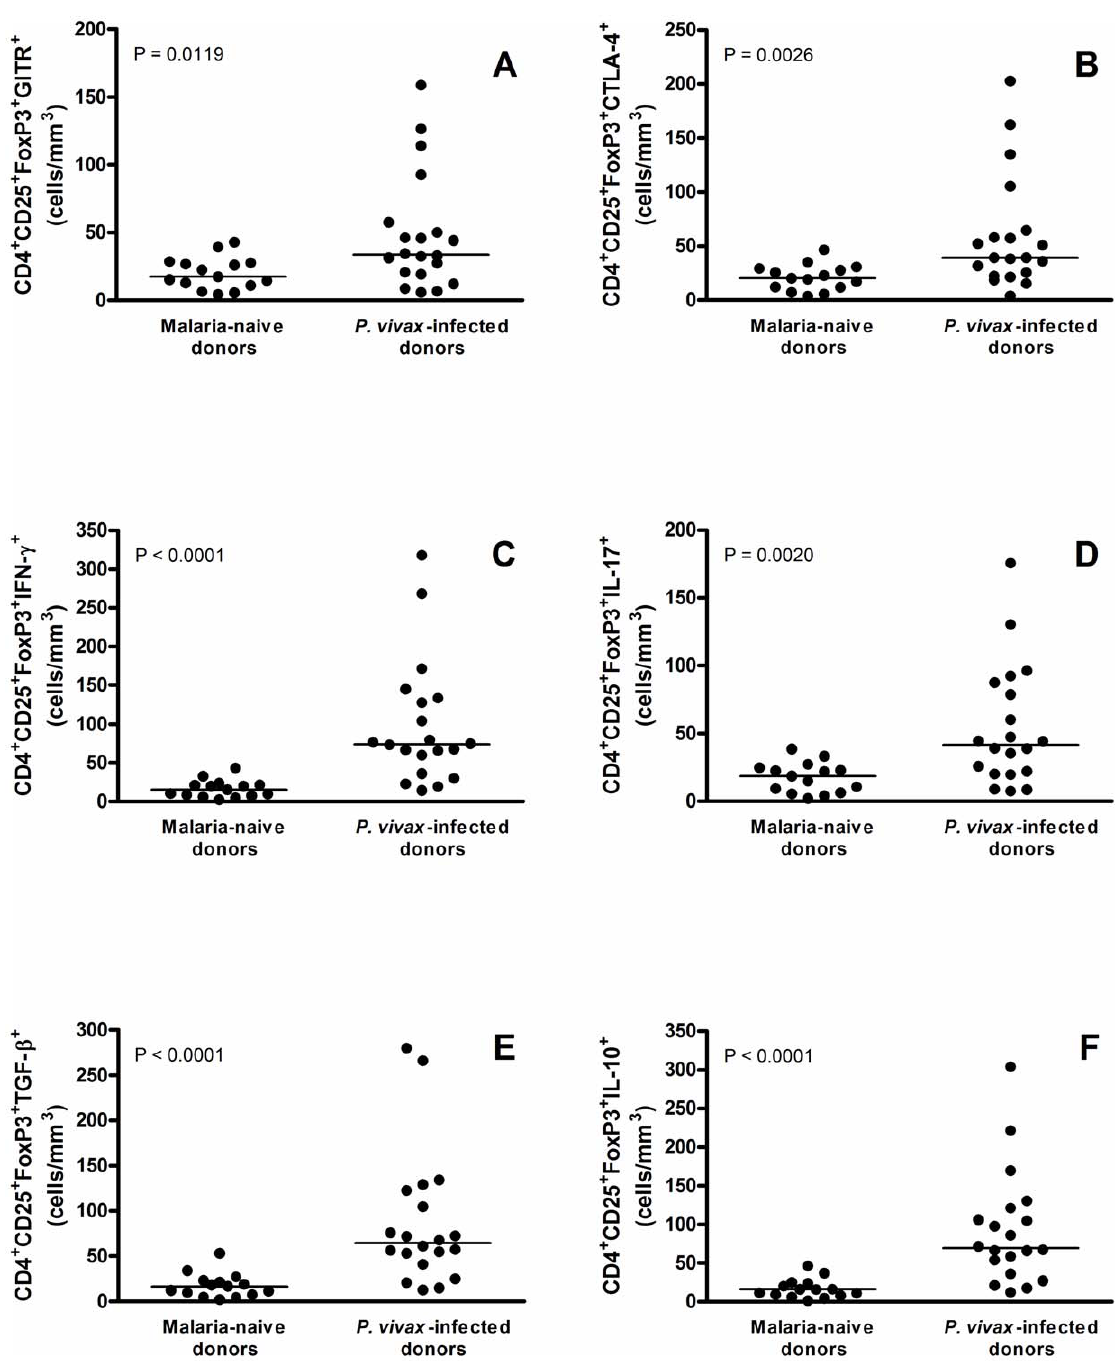
Figure 2. Flow cytometric analysis of surface markers (CTLA-4 and GITR) and cytokines (IFN- c , IL-17, TGF- b , and IL-10) in CD4 + CD25 + FoxP3 + regulatory T cells in malaria-naı¨ve and P.vivax -infected donors (n=15 and 20, respectively). Results were expressed as absolute numbers of cells expressing (A) GITR, (B) CTLA-4, (C) IFN- c , (D) IL-17, (E) TGF- b , and (F) IL-10. Absolute numbers (cells/mm 3 ) are indicated on Y-axis and lines represent median. Statistical differences were detected using Mann-Whitney U test and are indicated on the graphs with significant P values. doi:10.1371/journal.pone.0009623.g002 Figure 2B), when compared to malaria-naı¨ve donors. Flow